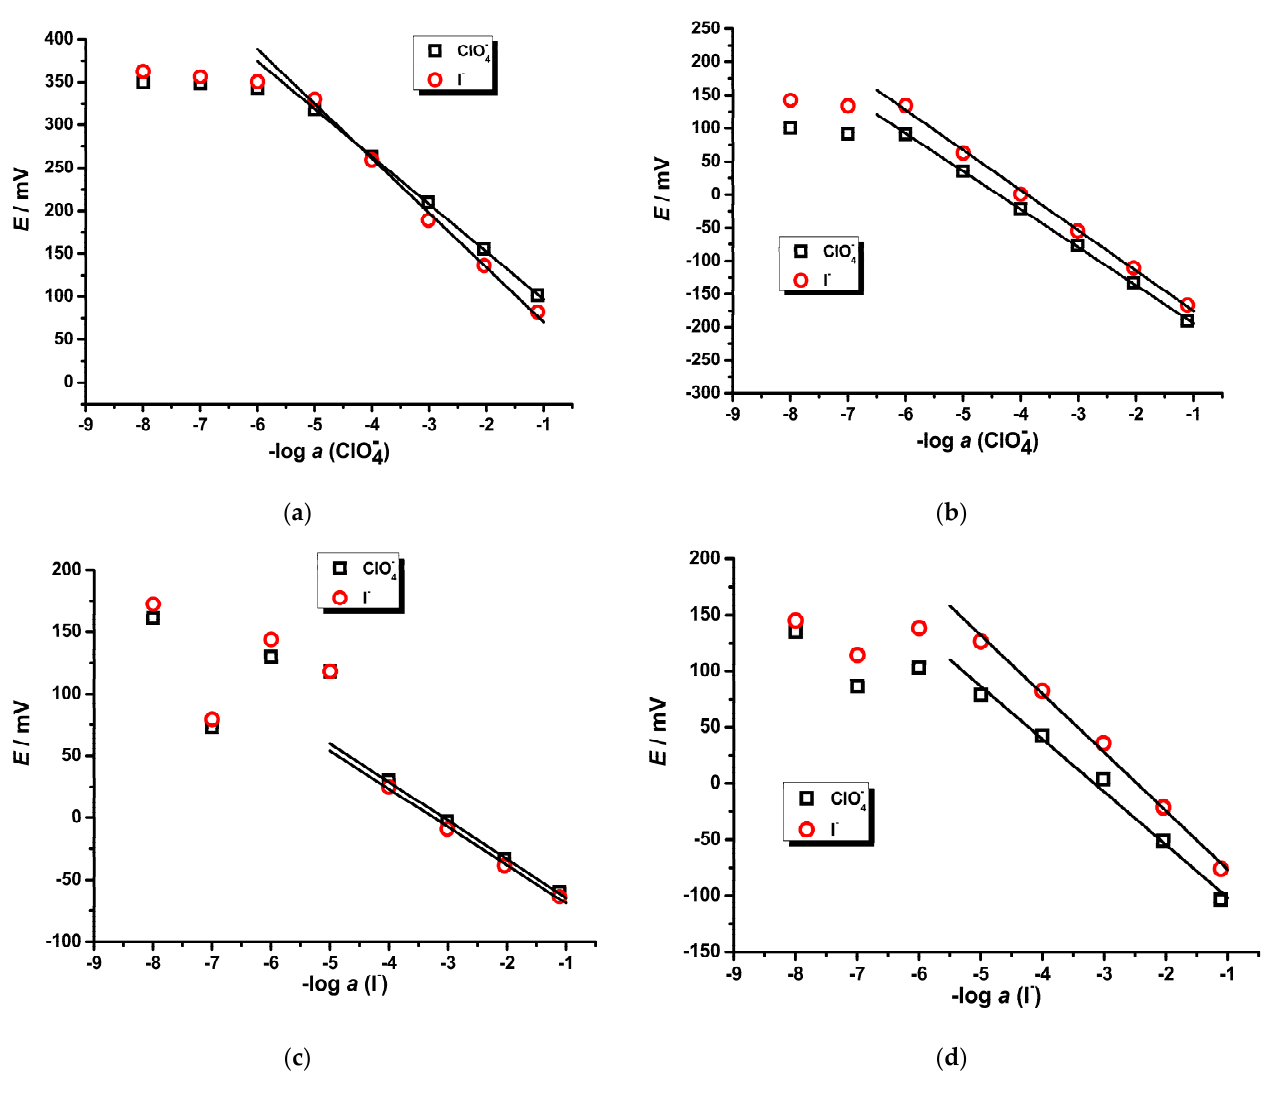
Figure 7. The calibration plot of perchlorate-ISE ( a , b ) or iodide-ISE ( c , d ) equilibrated in 0.01-M solution of anion (ClO 4 − /I − ): GC/PEDOT(Cl) electrode ( a , c ); GC/PEDOT(Cl)/ISM(3% BBU) ( b , d ). In the last step, the perchlorate-ISE was evaluated for analysis of real samples (Table 3). Water samples of different origins were chosen to simulate the variation of concentration of different interfering ions which contribute to the total ionic strength of the solution. Calibration plots were constructed for the concentration range 10 − 6 –10 − 4 M, while the spiked artificial samples (~20 μ M) were prepared in the middle of this concentration range. The results show that the slope was close to the Nernstian one for water samples originating from the lake and underground. On the contrary, the lowest value was deter- mined in the case of sea water, probably due to high chloride concentration in the Baltic